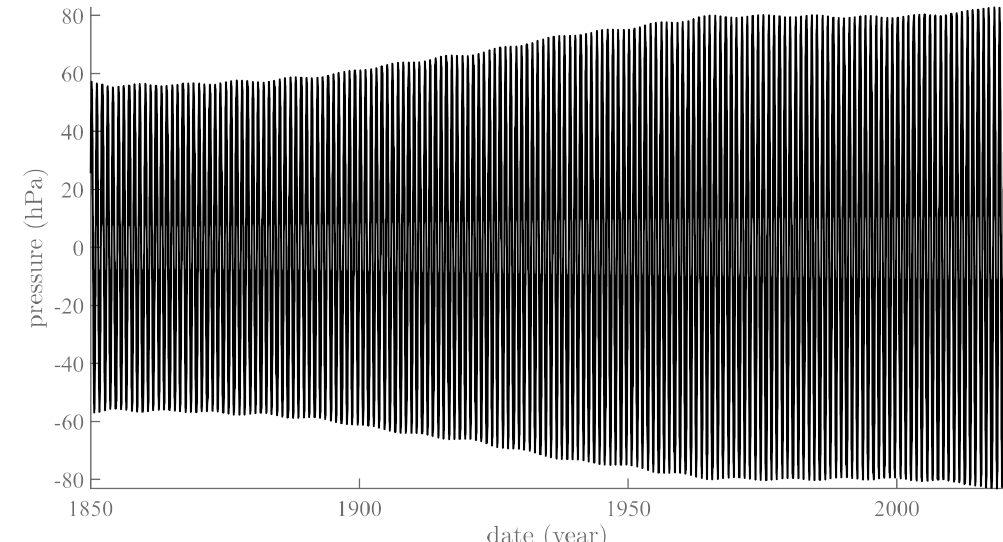
Figure 3. The iSSA annual component of sea level pressure SLP from 1850 to the